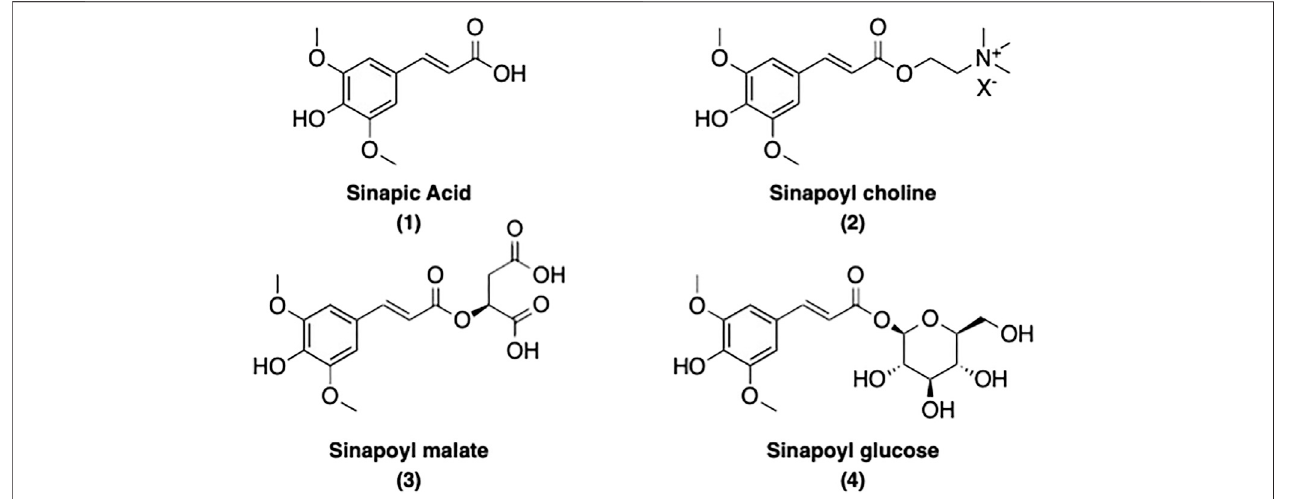
FIGURE 1 | Structures of SinA and its main corresponding esters present in this